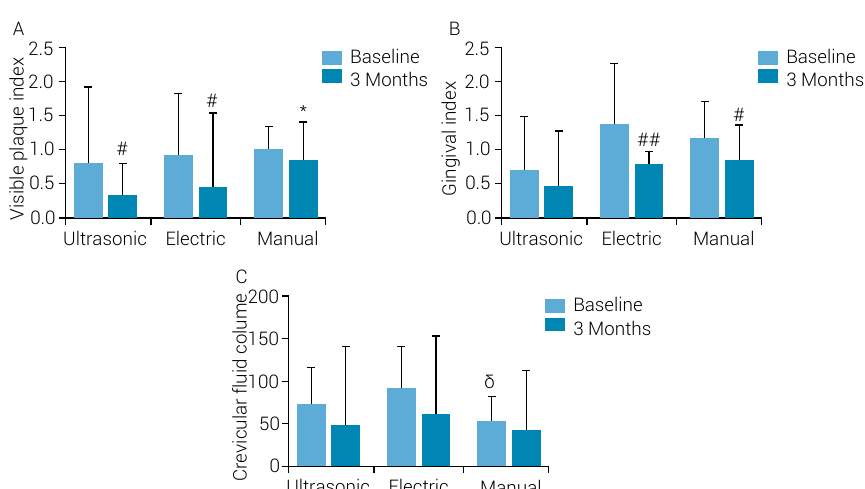
Figure 4. Representative graphs of the clinical analysis of the A) visible plaque index, B) gingival index, and C) crevicular fluid volume evaluated at the baseline and after 3 months of the toothbrushes use. *p<0.05-Higher visible plaque index than the US group at 3 months-Kruskall-Wallis complemented by Dunn; #p < 0.05; ##p < 0.01- Lower visible plaque index and gingival index than at baseline-Wilcoxon; δp < 0.05- Less crevicular fluid volume than the E group at baseline-Kruskall-Wallis complemented by Dunn.